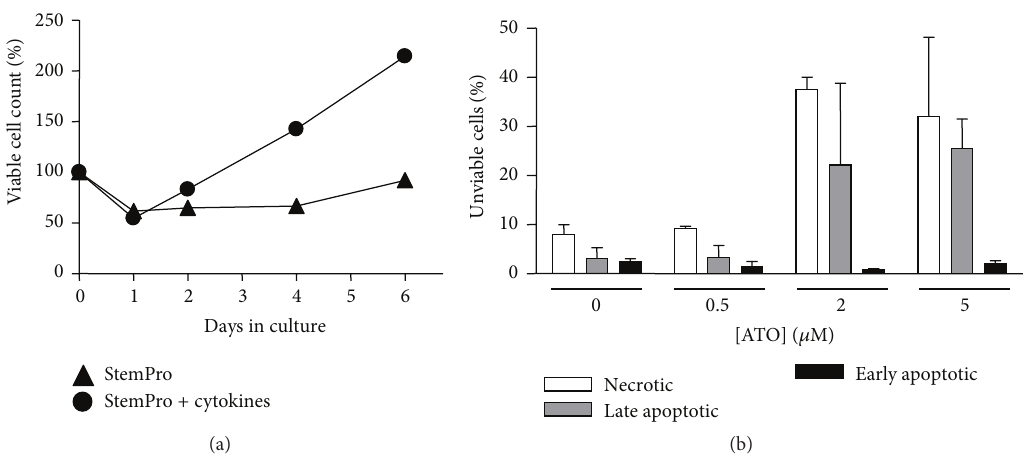
Figure 1: Proliferation and ATO-induced cytotoxicity of BM CD34+ cells. (a) Comparison of cell proliferation when cultured in StemPro-34 medium without and with added cytokines. Viable cells were identified by trypan blue exclusion. Data are mean from two experiments. (b) Effects of ATO at different concentrations on cell viability assessed by flow cytometry. Cells were treated with ATO for 7 days in StemPro-34 ( 𝑛 = 2